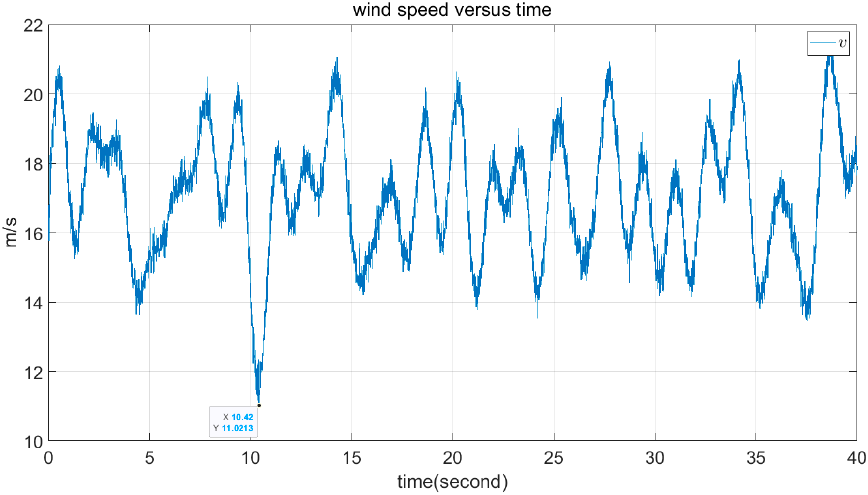
Figure 5. The profile of time series wind speed.